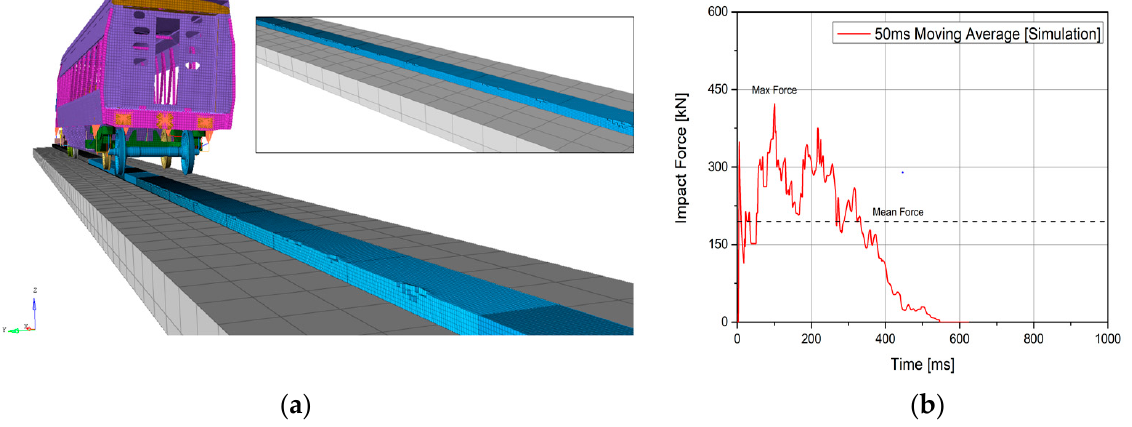
Figure 10. Impact simulation results. ( a ) Damage of the DCP after impact. ( b ) Impact force on the DCP. Table 4. Impact force comparison of Olson model and simulation. Curve Radius (m)